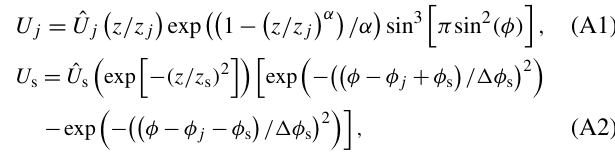
Table A2. Piecewise constant vertical gradients used to define the horizontally constant temperature profile T (z)